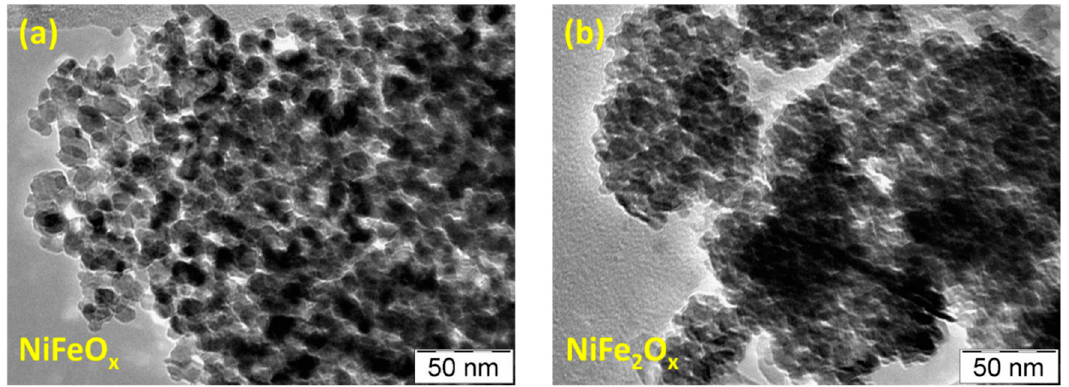
Figure 3. TEM images of the NiFeO x ( a ) and NiFe 2 O x ( b ) catalysts.